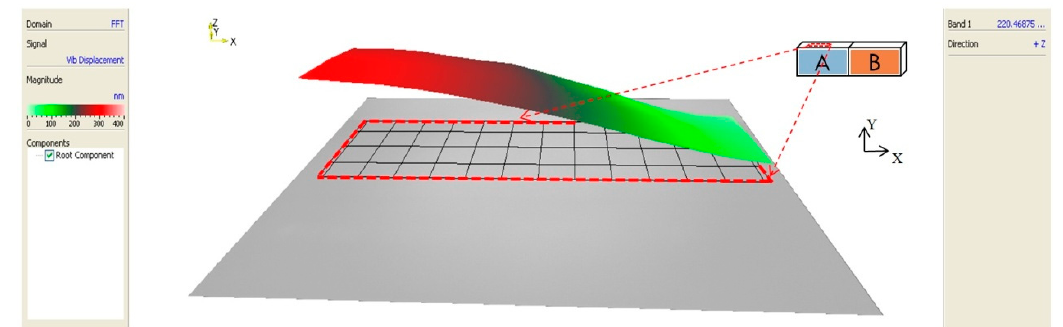
Figure 5. Displacement profile of a driven piezoelectric material.